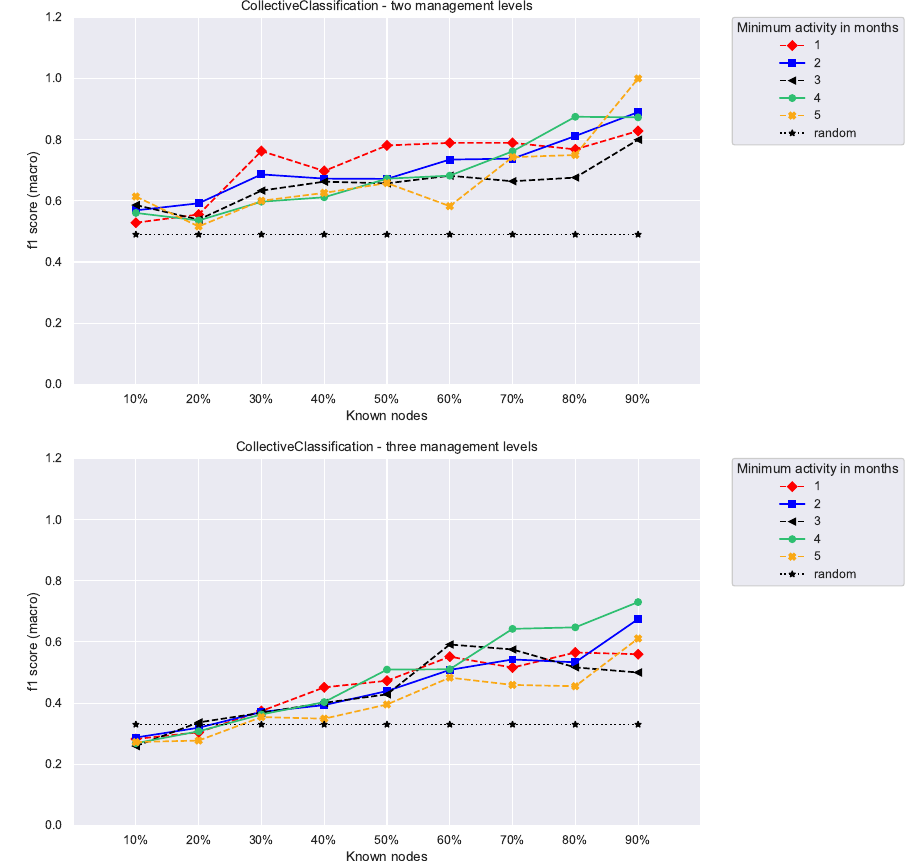
Figure 8. The result of the collective classification of three groups for the Enron company